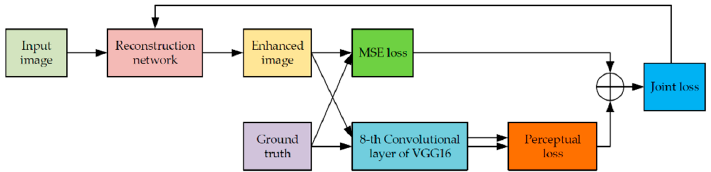
Figure 9. The flow of calculating the joint loss for optimizing the parameters of the reconstruction network.